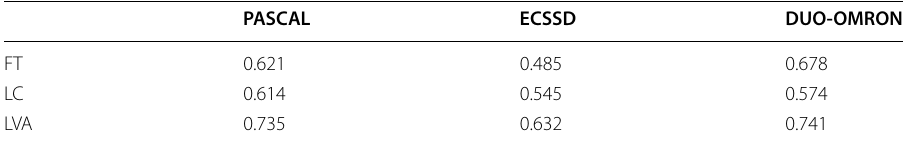
Table 5 MAE index of three